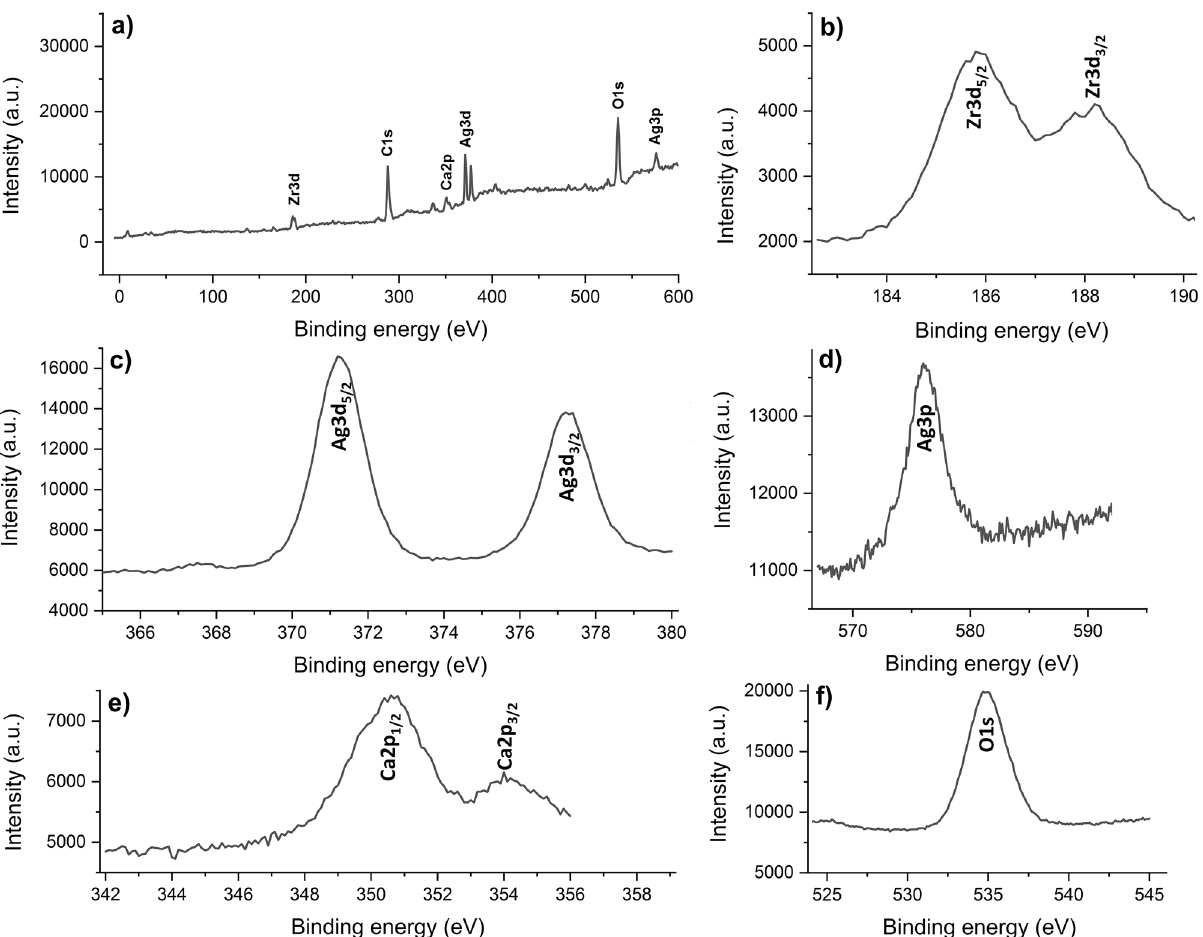
Figure 3. XPS spectra of AgNPs-doped MAO surface produced at 15 min: ( a ) Survey, ( b ) Zr3d, ( c ) Ag3d, ( d ) Ag3p, ( e ) Ca2p and ( f )